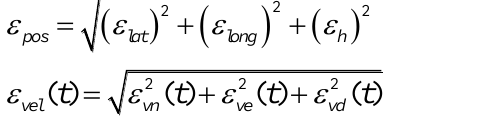
Figure 1: A corner detection scenario